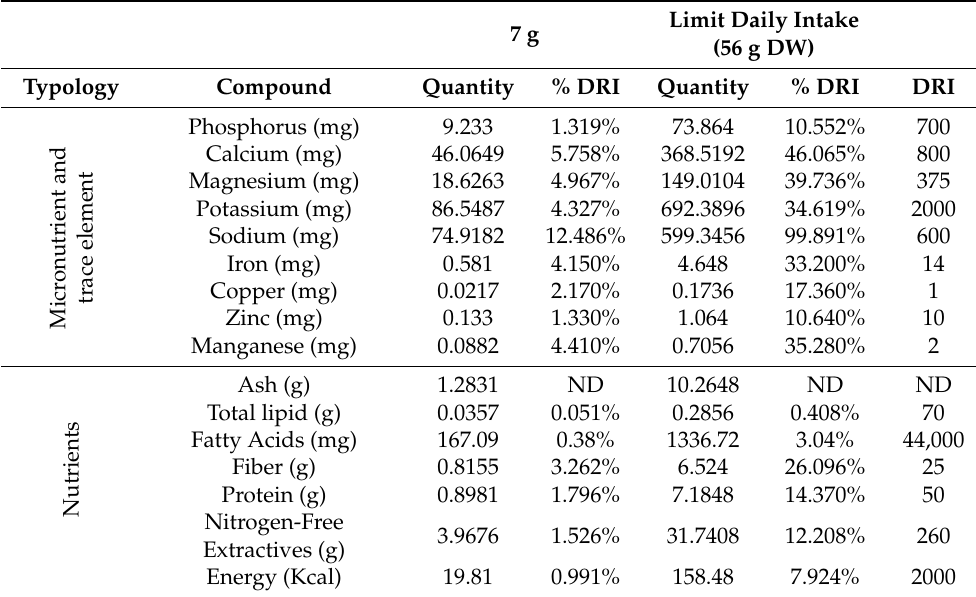
Table 12. Nutritional value in 7 g of L. ochroleuca according to the established Dietary Reference Intake (DRI) and its food intake limit using the DRI [5,9]. ND—not determined.